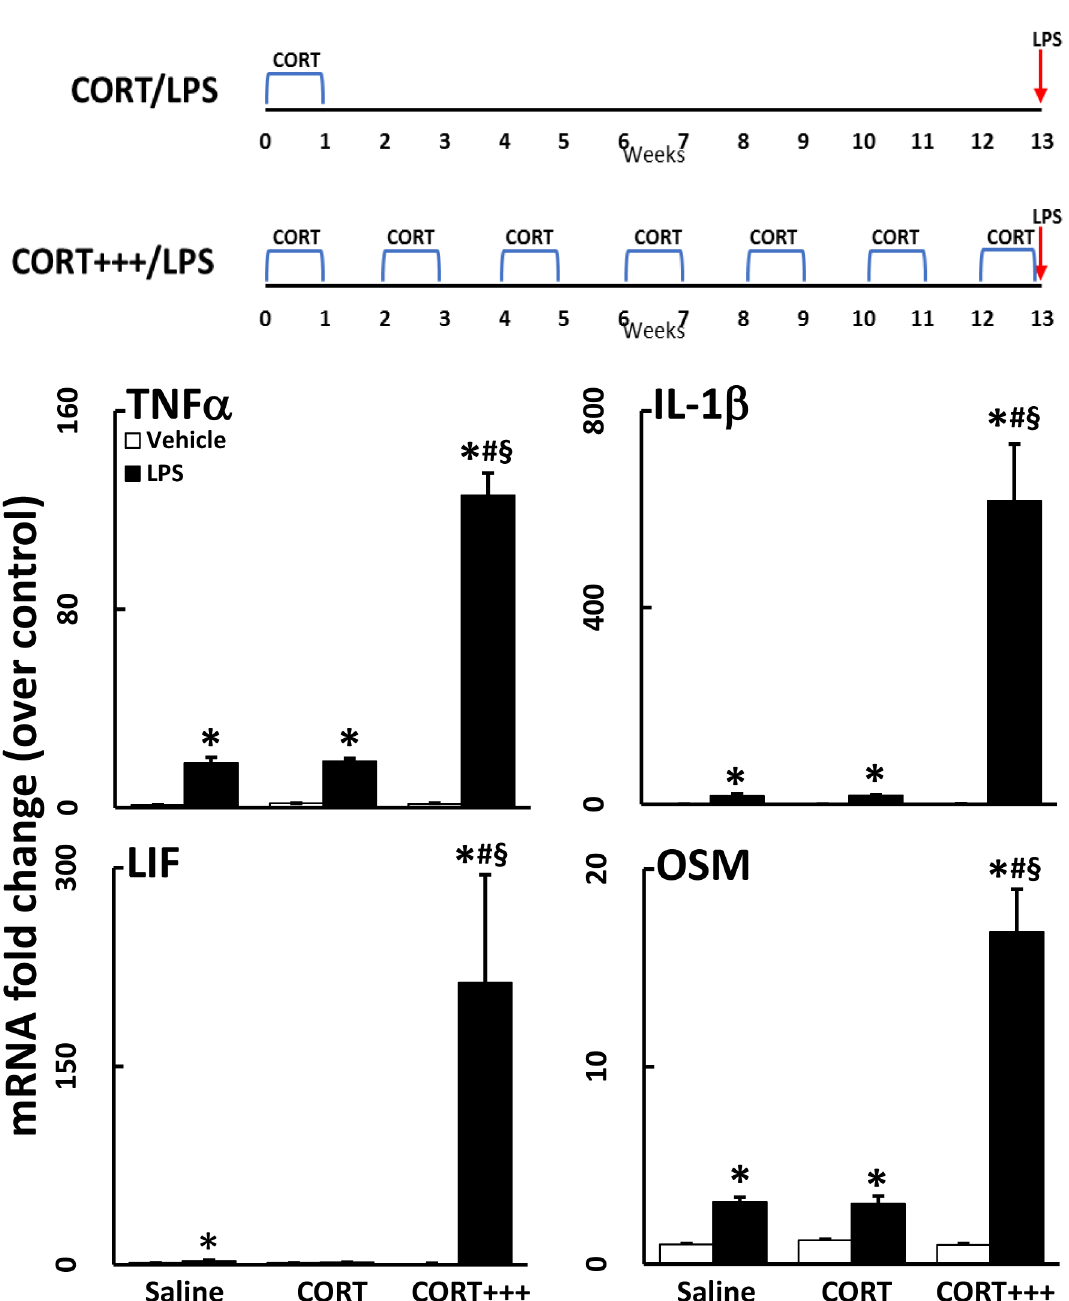
Fig 7. Successive waves of CORT for 90 days greatly exacerbates LPS-induced neuroinflammation. Mice were treated with CORT (200 mg/L 0.6% EtOH) for 7 days in the drinking water followed either by 90 days without (CORT) or 90 days of bimonthly, 7 day CORT exposures (CORT+++). LPS (2 mg/kg, s.c.) was administered on day 97. TNF α , IL-1 β , LIF, and OSM mRNA levels were measured in samples prepared from cortex collected 6 hours after LPS exposure. Data represent mean ± SEM (n = 5 mice/group). Statistical significance of at least P < 0.05 is denoted by (cid:3) as compared to appropriate control, # as compared to LPS alone, and § as compared to